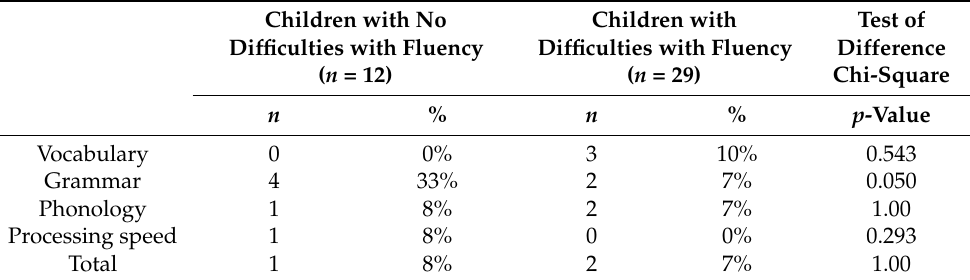
Table 5. Cases with dissociative scores outside the density ellipse ( N =